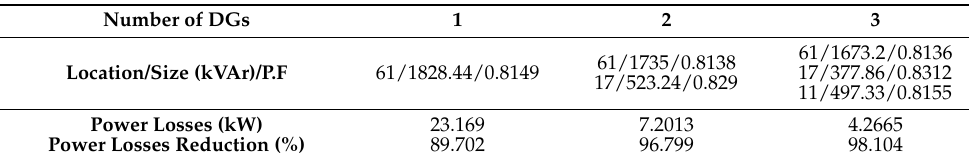
Table 3. Configuration of PQ ‐ type DG installed on the IEEE ‐ 69 RDS.